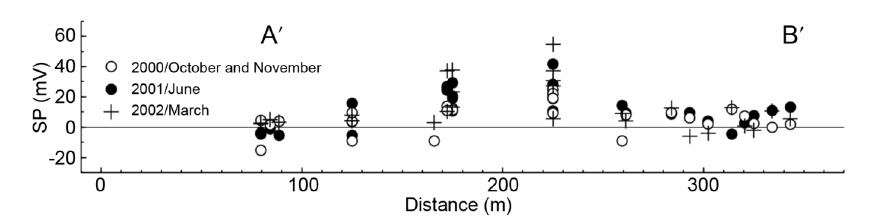
Fig. 8. SP profiles along A l -B l in fig. 6a. Data within a solid square are projected onto the